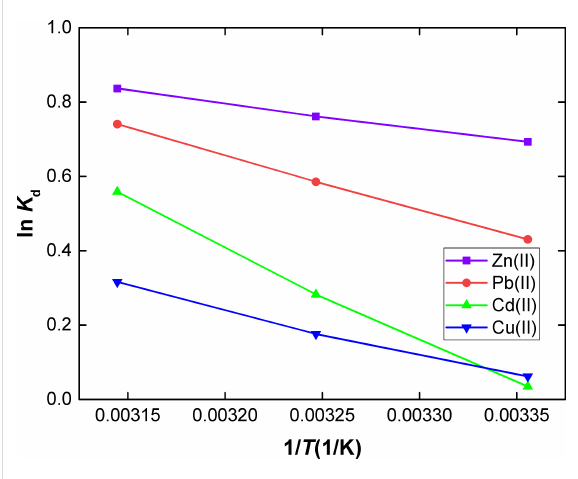
Figure 10: Effect of temperature for the sorption of metal ions onto SiNL (shaking time 60 min, pH 6, adsorption dose: V = 10 mL, m = 10 mg of SiNL at optimum concentration: 100 ppm of each metal).